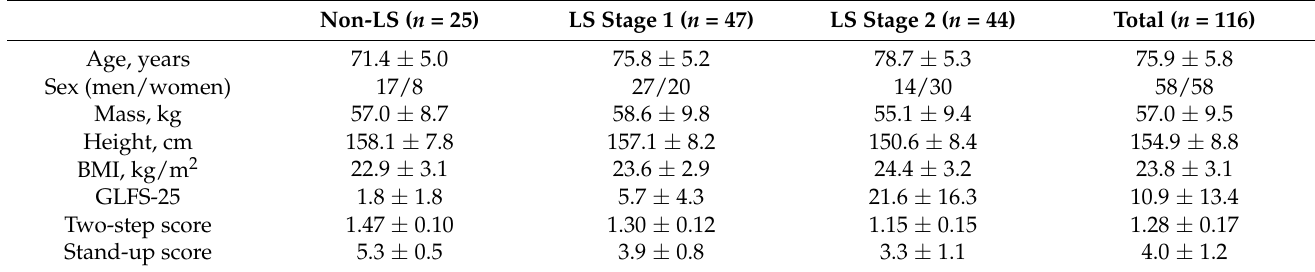
Table 1. There was a significant difference in the sex ratio among the LS groups ( p = 0.006). Table 1. Characteristics of the enrolled participants ( n = 116) according to the LS